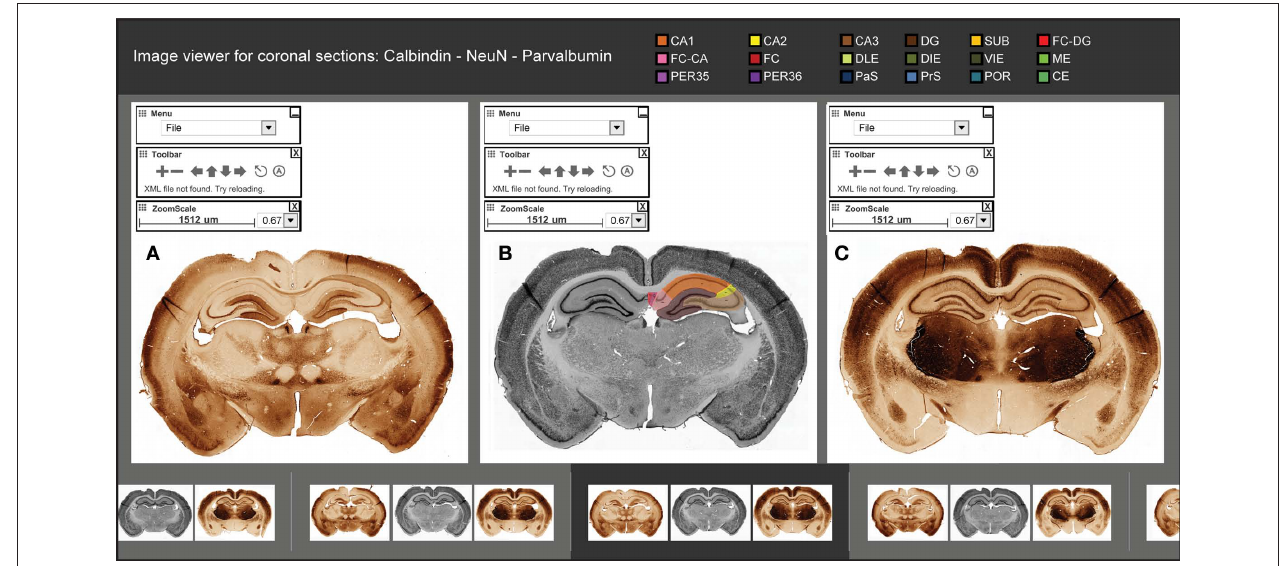
parvalbumin (C) . Anatomical segmentations are provided as a color-coded graphical overlay on one side of the NeuN stained sections (B) . The graphical overlay can be rendered active (visible) or deactive. Images can be individually zoomed and panned in each viewer panel, or synchronized to corresponding positional and zoom scale values facilitate comparison across the viewer